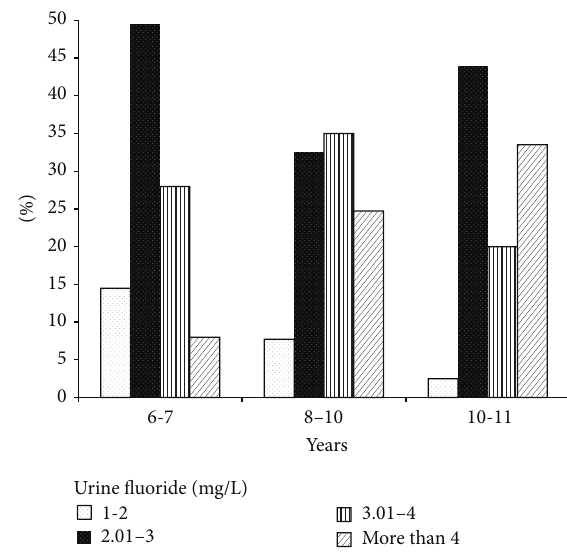
Figure 1: Urine fluoride concentration in children in the study area by age group as